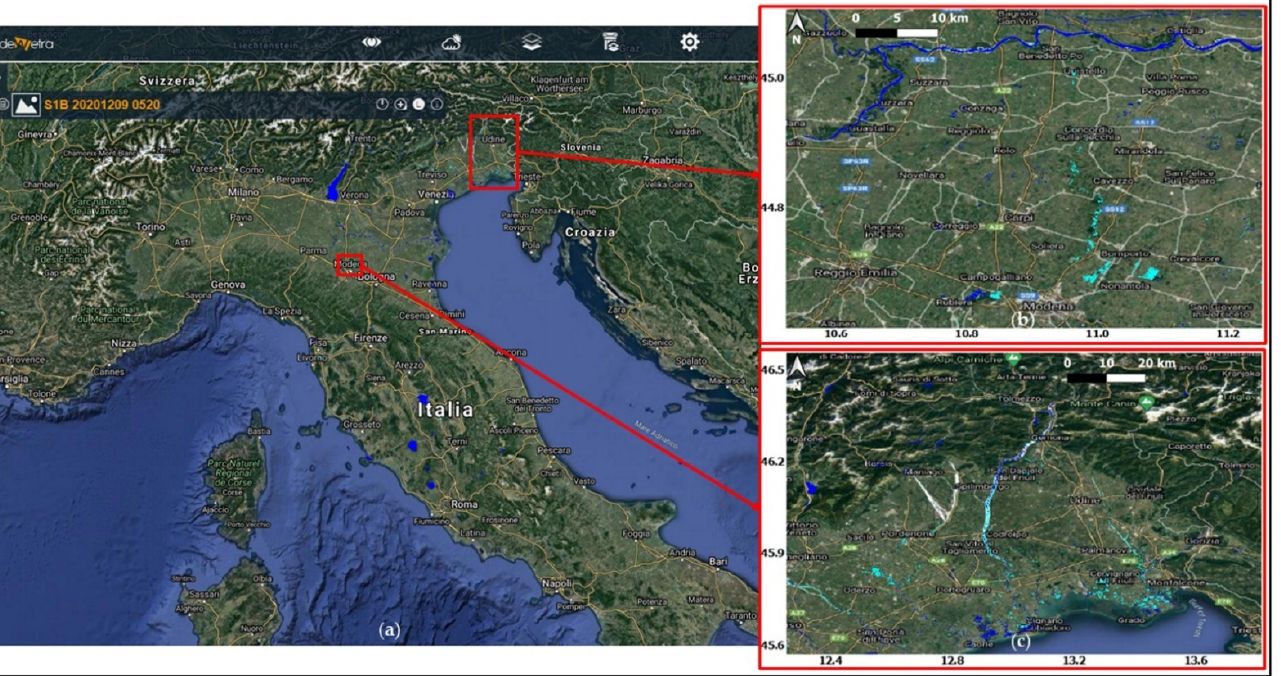
Figure 14. Typical AUTOWADE’s output generated using the S1 acquisition performed on 9 December 2020 (orbit 95, the same considered to produce Figure 5). Panel ( a ) synoptic view; panels ( b , c ): zoom on two flooded areas. Blue: permanent water; cyan: floodwater.